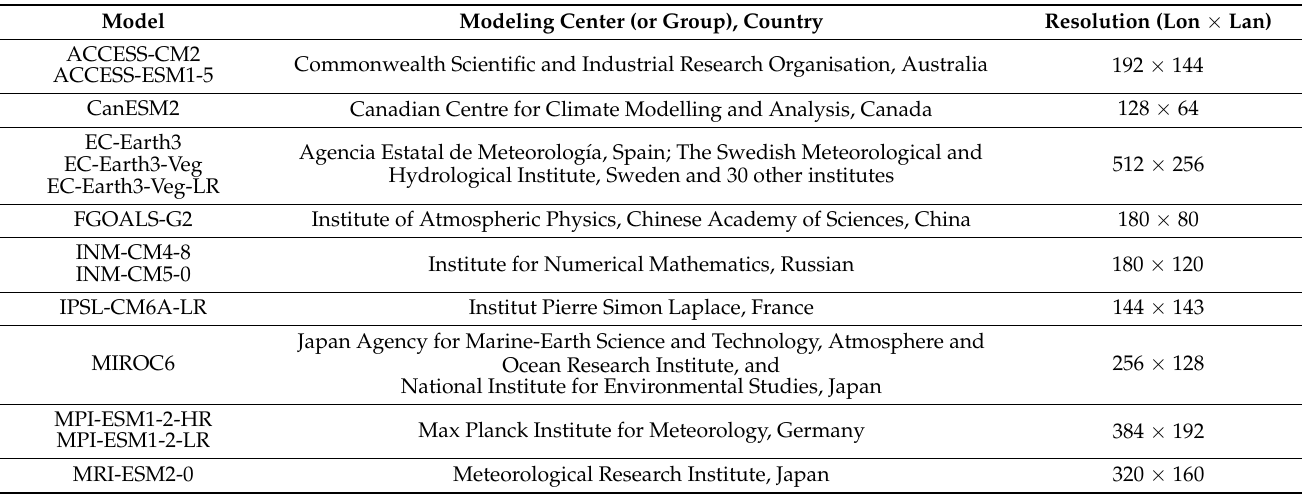
Table 1. Basic information of the 14 selected models in the CMIP6.